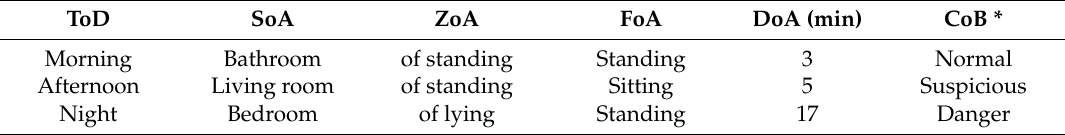
Table 4. Classification of exemplary behaviors.